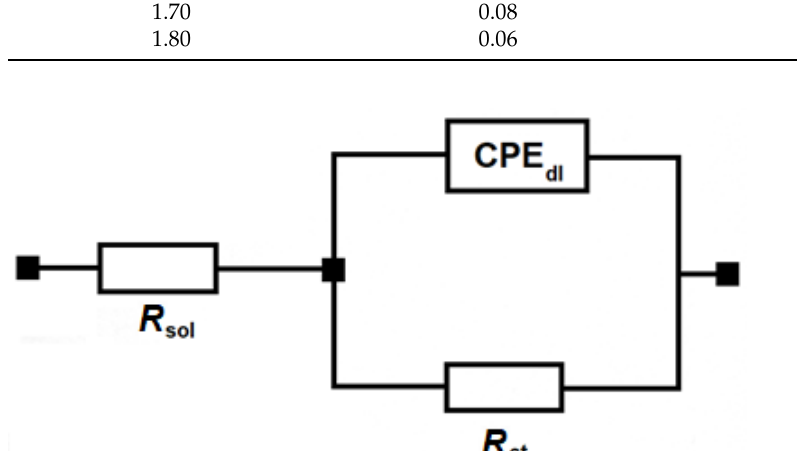
Figure 6. Nyquist impedance plots for alkaline water electrolysis process (total impedance meas- ured for a single-cell electrolyser unit), carried out for indicated cell voltages, on cathodes of un- modified ( a ) and palladium-activated nickel foam material ( b ), recorded in 8 M KOH at 45 °C.